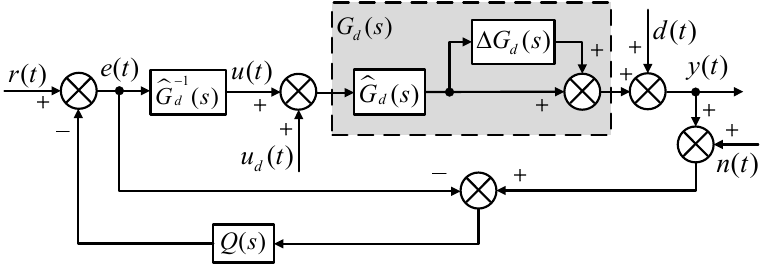
Figure 12. The feed ‐ forward inverse control based on simple disturbance observer. Figure 12. The feed-forward inverse control based on simple disturbance